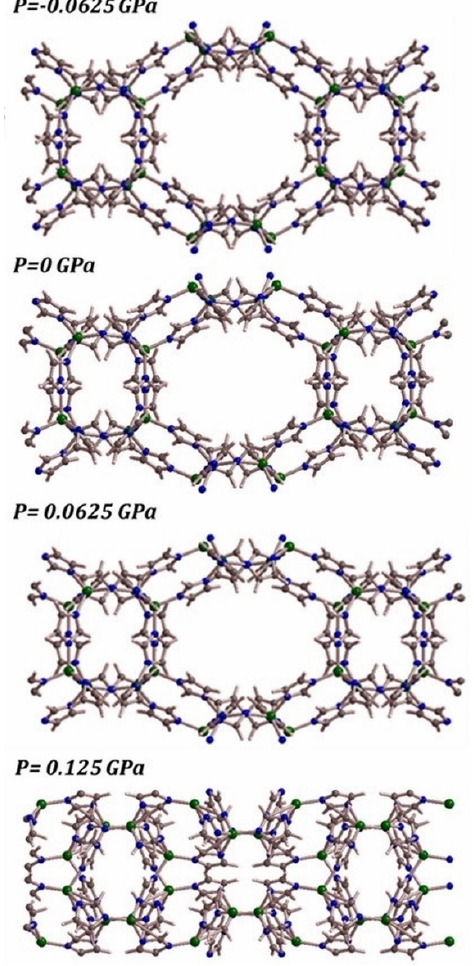
Figure 6. View of crystal structure of ZIF-75 from [1 0 0] crystallographic direction at four different pressures, P = − 0.0625, 0.0, 0.0625, and 0.125 GPa. The subfigure corresponding to P = 0.125 GPa provides a view of the crystal structure after the pressure-induced phase transition. Color code: Zn—green; N—blue; C—gray; O—red;